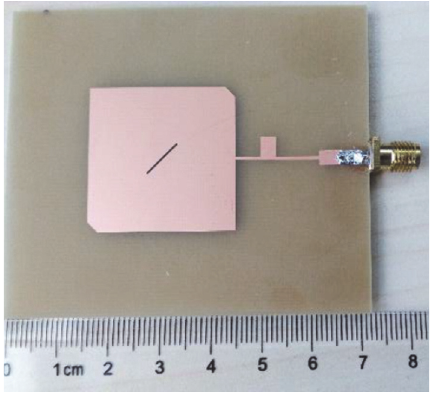
Figure 8: Prototype of the proposed